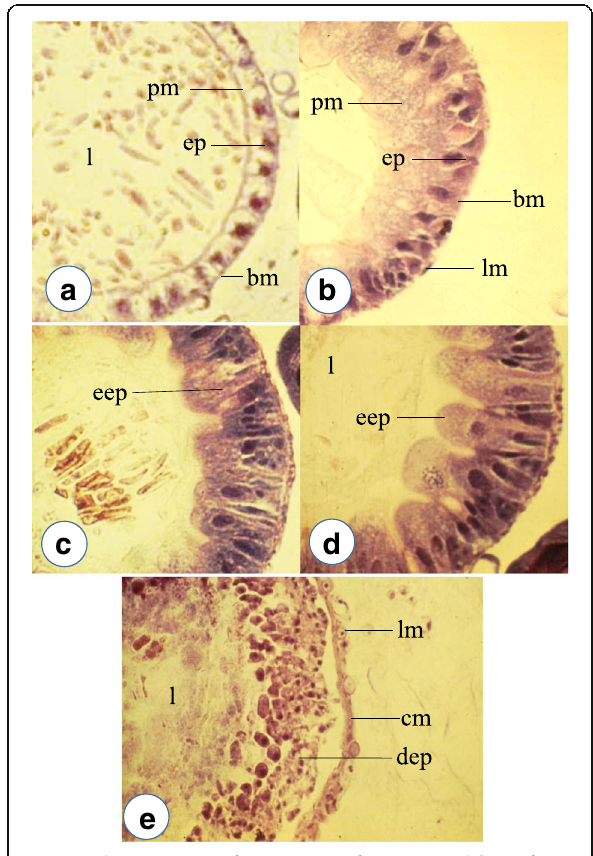
Fig. 2 Mid-gut structure after ingestion of B.t. a Control. b – e After 1, 2, 3, and 4 days from infection. (bm) basement membrane, (cm) circular muscle, (dep) disintegrated epithelial cells, (ep) epithelial cell, (eep) elongated epithelial cell, (lm) longitudinal muscle, (l) lumen, (pm) peritrophic